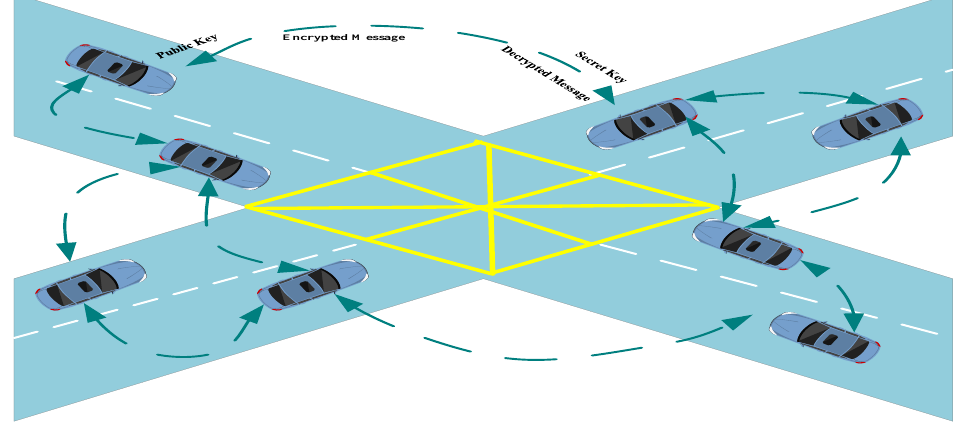
Figure 11. Use of general asymmetric cryptography approach for securing vehicle to vehicle communication.